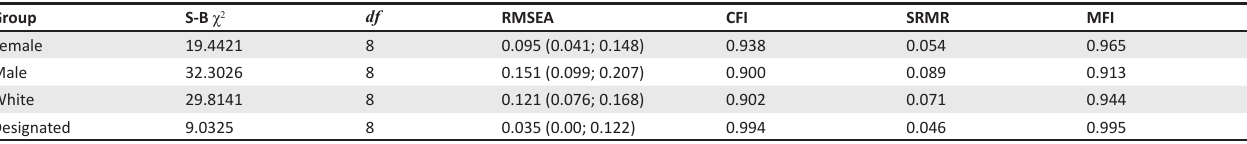
TABLE 4: Goodness-of-fit statistics of the hope construct across groups. Group